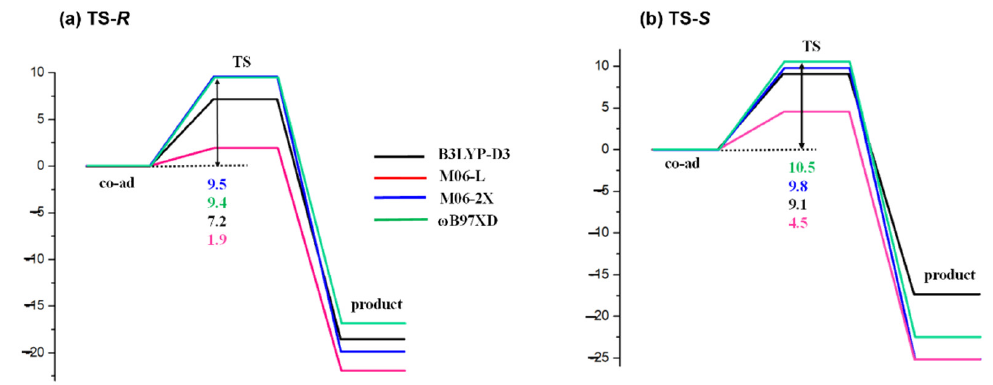
Figure 7. Activation barriers (kcal/mol) via TSs ( a ) TS- R ( b ) TS- S on the In-MOF in toluene calculated by different functionals.